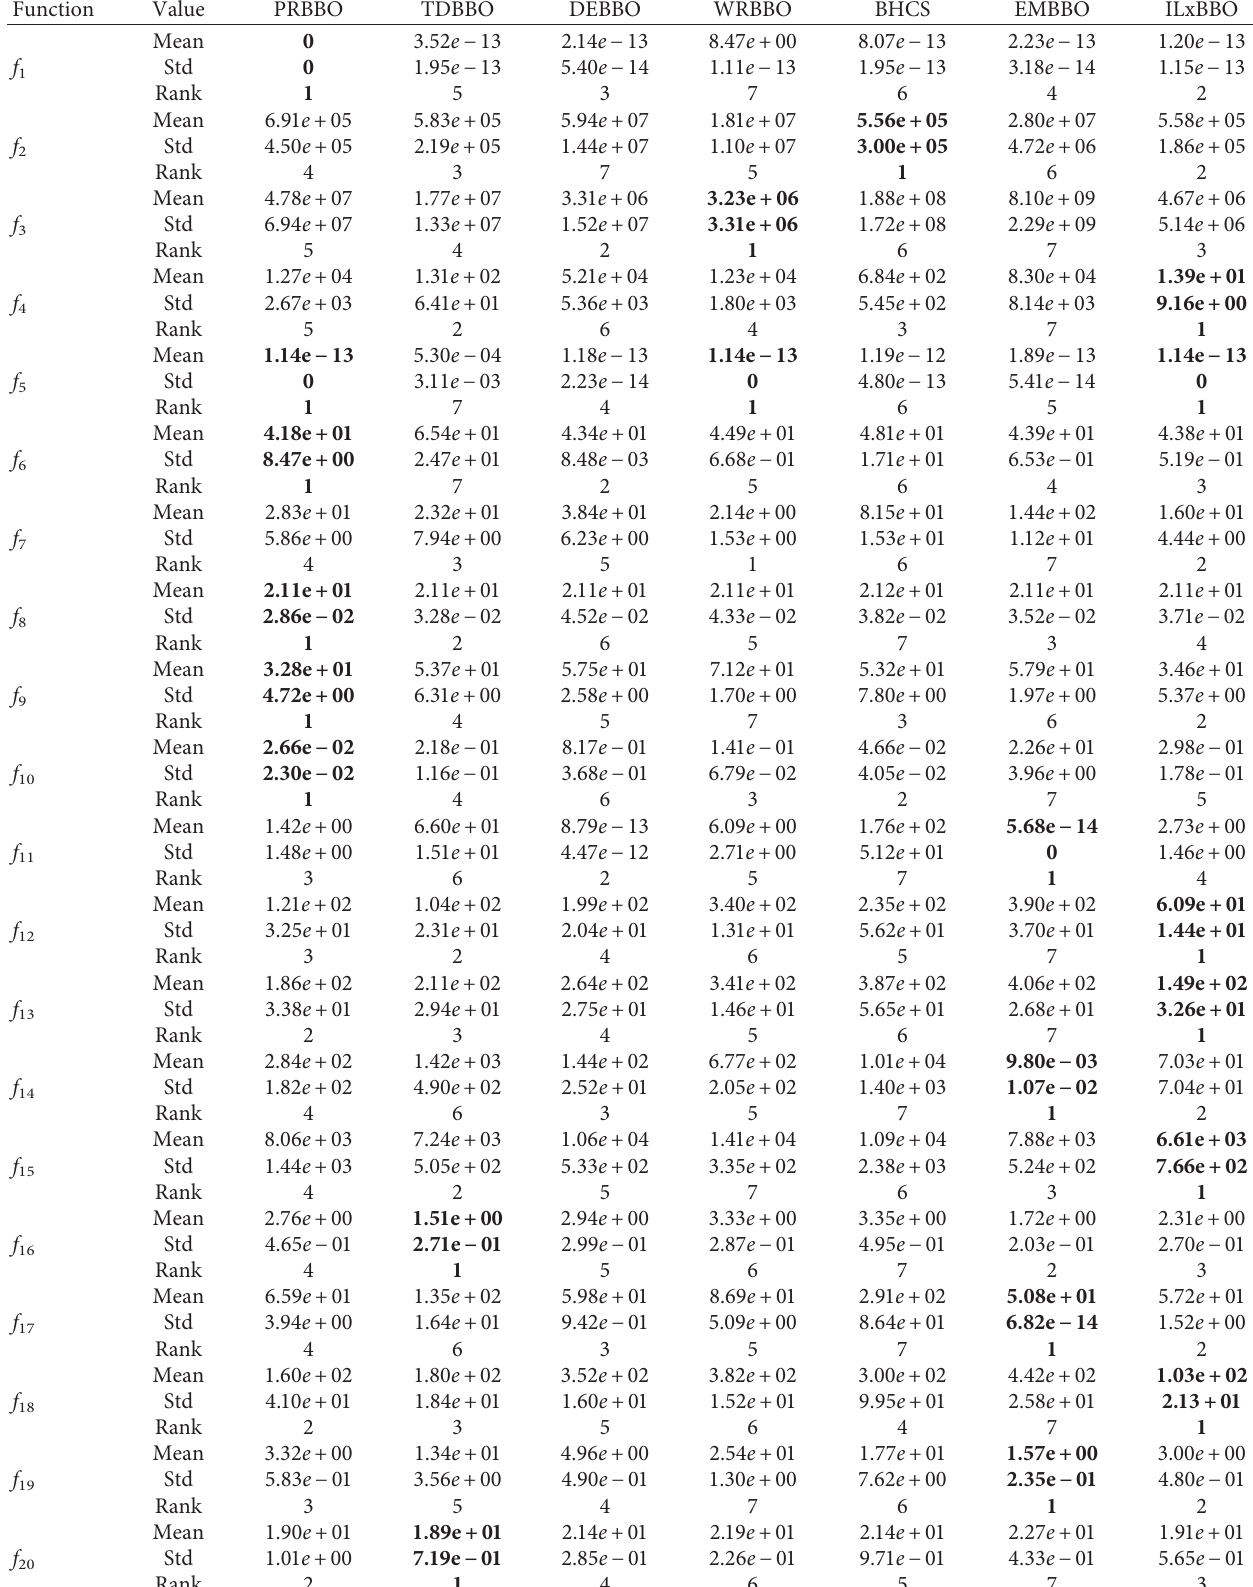
Table 3: Comparison results among ILxBBO and BBO’s variants on the 50-dimensional functions.